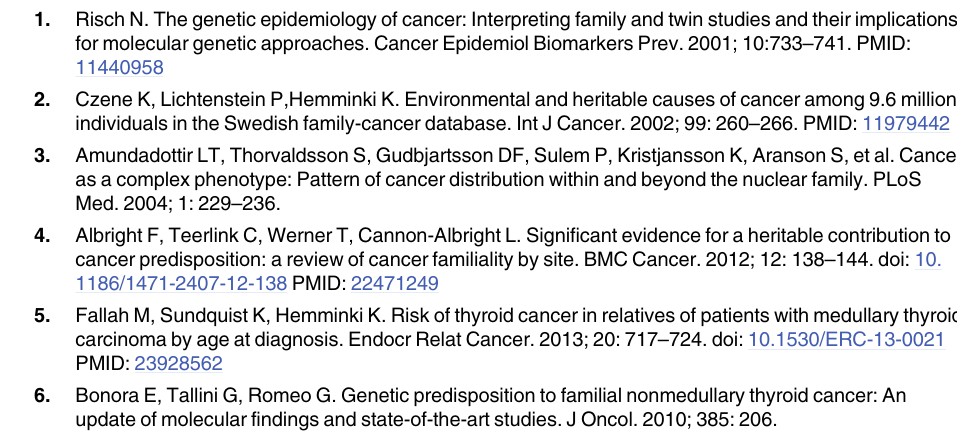
S1 Fig. Pedigrees of 7 families genotyped for the HABP2 G534E (c.1601G > A) variant in available samples. S2 Fig. qPCR reaction in paired tumor and unaffected tissue from 8 PTC patients. S3 Fig. qPCR reaction in normal kidney, liver, breast and brain. S4 Fig. qPCR reaction using 2 different qPCR assays in normal kidney, liver, breast and brain. S1 Table. Clinical and demographic information on cases and